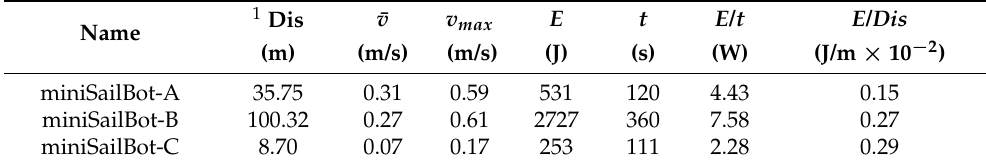
Figure 14. Local testing experiments. ( a – c ) are automatic sailing with miniSailBot-A, miniSailBot-B and miniSailBot-C, respectively. Table 1. Performance of miniSailBots in